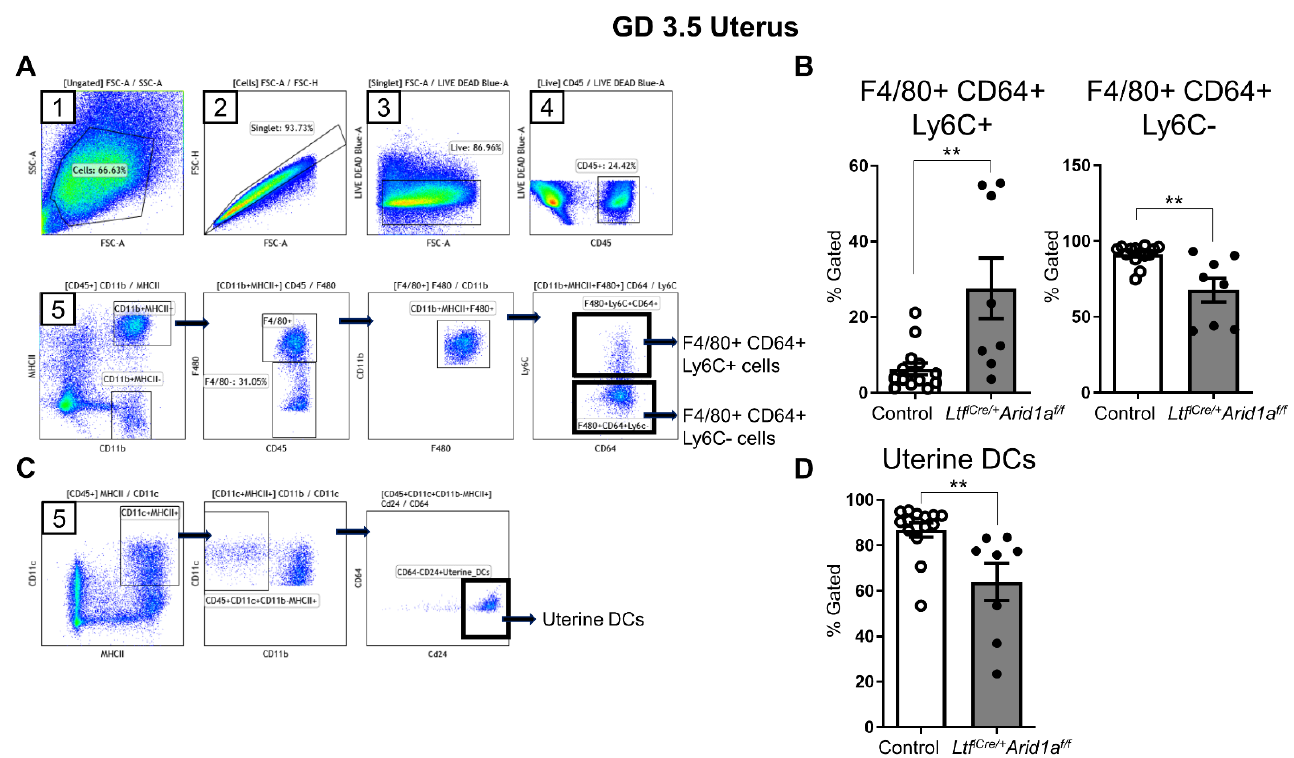
Figure 6. F4/80+ CD64+ Ly6C+ cells are increased, while uDCs are decreased in Ltf iCre/+ Arid1a f/f uteri at GD 3.5. ( A ) The flow gating strategy to identify F4/80+ CD64+ Ly6C+ and F4/80+ CD64+ Ly6C- cells in the mouse uterus is shown. ( B ) The percentage Gated proportion of F4/80+ CD64+ Ly6C+ cells (left) and F4/80+ CD64+ Ly6C − (right) cells in control ( n = 14, empty bar) and Ltf iCre/+ Arid1a f/f ( n = 8, grey bar) uteri at GD 3.5 is shown. ( C ) The flow gating strategy to identify uDCs in the uterus is shown. ( D ) The percentage Gated proportion of uDCs in control ( n = 14, empty bar) and Ltf iCre/+ Arid1a f/f ( n = 8, grey bar) uteri at GD 3.5. The graphs represent the mean ± SEM. **, p < 0.01. Abbreviations: Arid1a , AT-rich interaction domain 1A; CD64, cluster of differentiation 64; DCs, dendritic cells; F4/80, EGF-like module-containing mucin-like hormone receptor-like 1; GD, gestation day; Ltf , lactoferrin; Ly6c, lymphocyte antigen 6C.